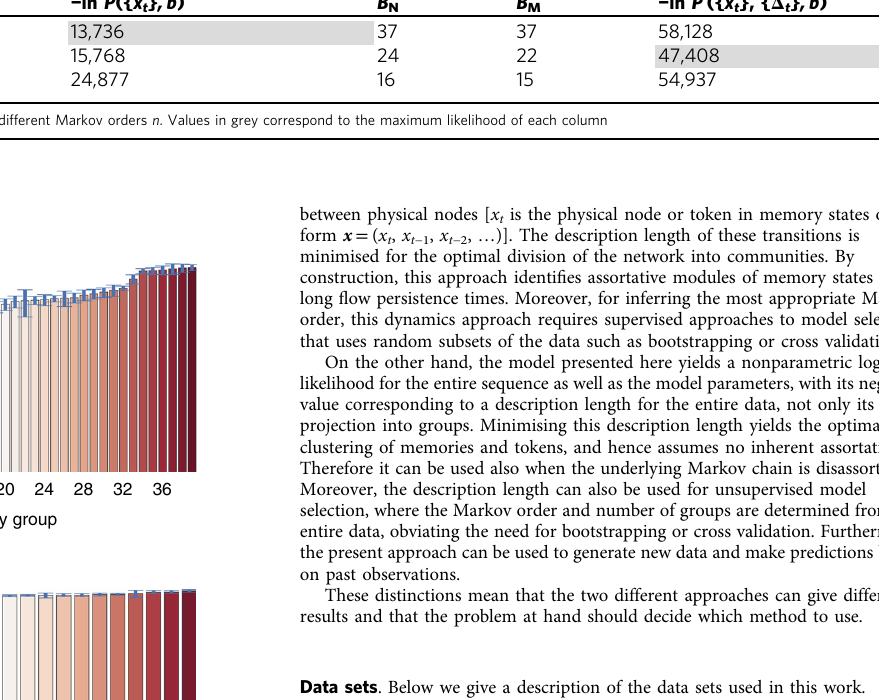
Table 3 Joint likelihoods for discrete- and continuous-time Markov models Discrete time